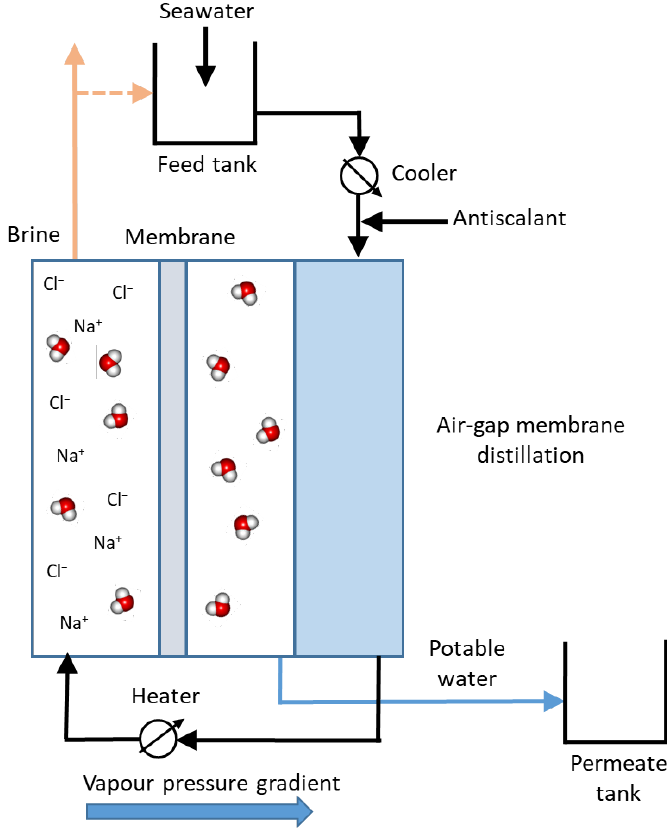
Figure 8. Schematic representation of an air-gap Membrane Distillation system.